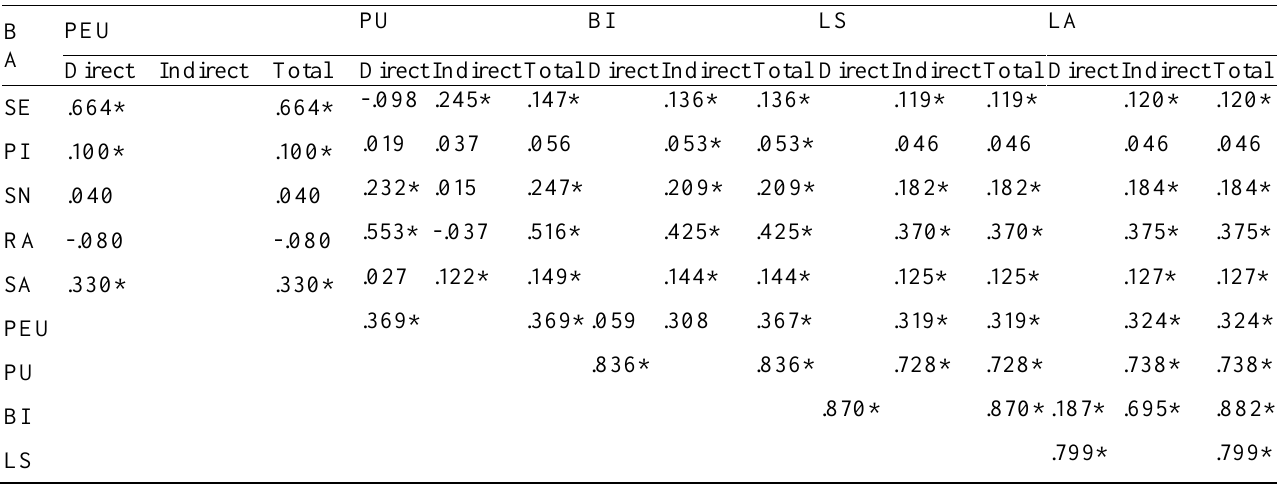
Direct, Indirect, and Total Effects of the Research Model